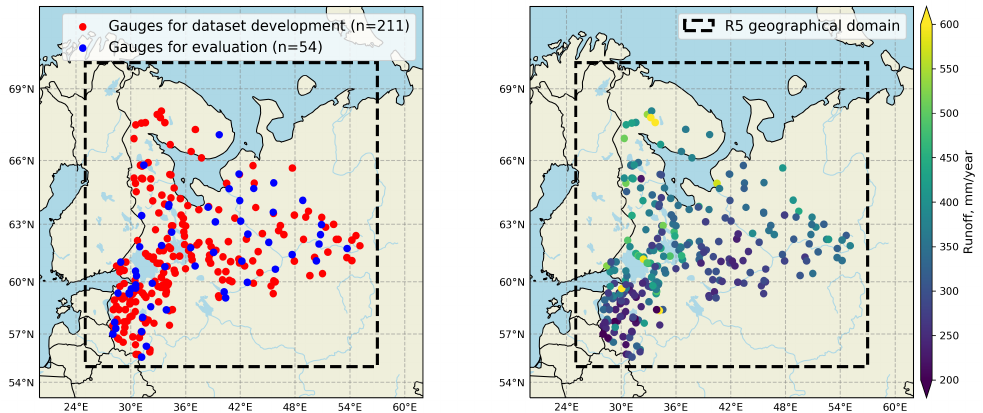
Figure 7. Spatial distribution of gauges that have been used for dataset development (i.e., donor basins) and performance evaluation ( left plot ), and the corresponding values of mean annual runoff ( right plot